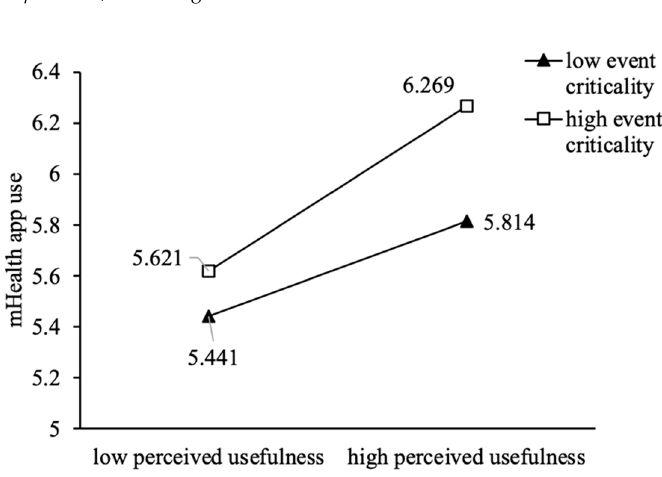
Figure 3. The Moderating Effect of Event Criticality on Perceived Usefulness.